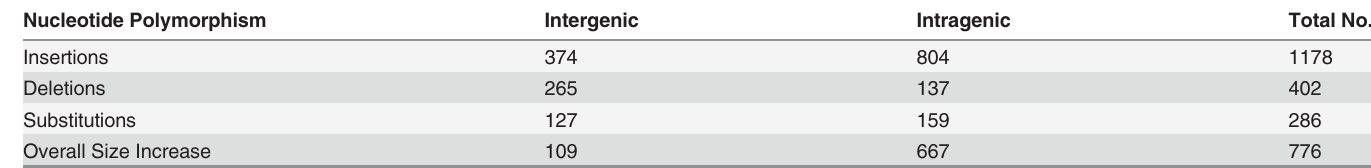
Table 1. Nucleotide polymorphisms in genome of WY-00W4114 compared to WY96-3418 and overall base pair size increase in WY-00W4114.